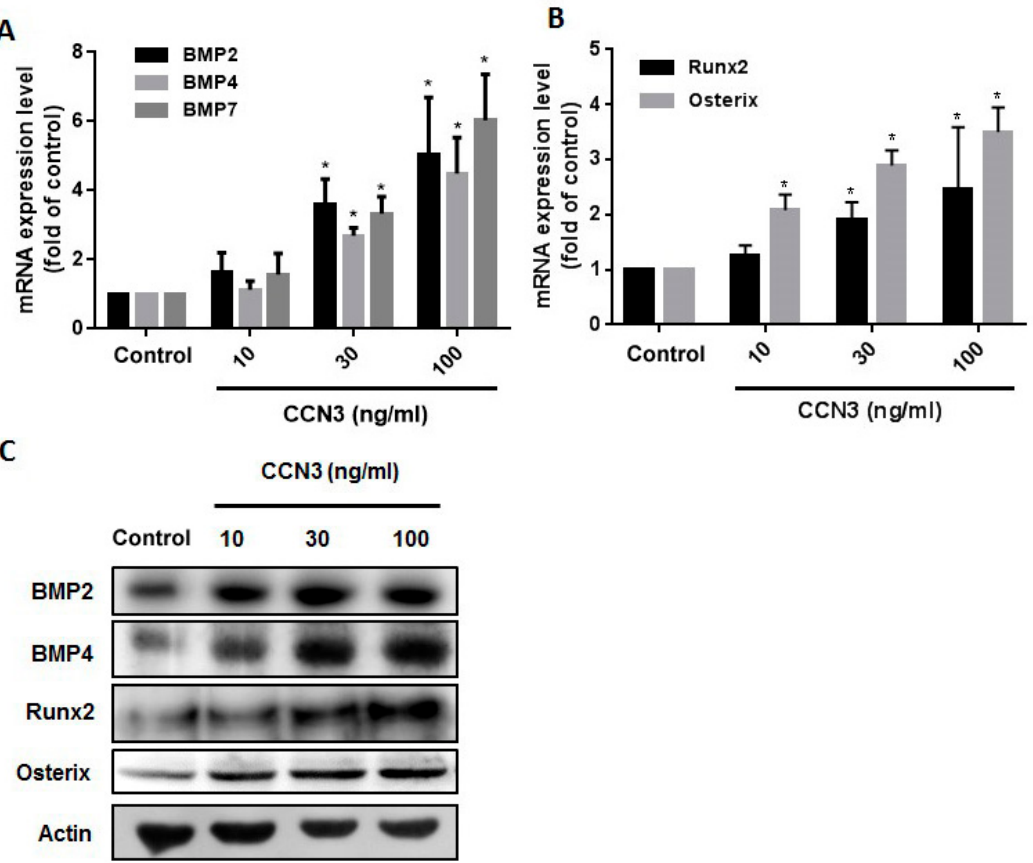
Figure 2. CCN3 enhances osteogenic factor expression in osteoblasts. ( A , B ) Osteoblasts were treated with CCN3 (10–100 ng / mL) for 24 h; mRNA and protein expression were examined by qPCR ( A , B ) and Western blot assay ( C ), respectively. Results are expressed as the mean ± S.E. * p < 0.05 as compared with the control group.